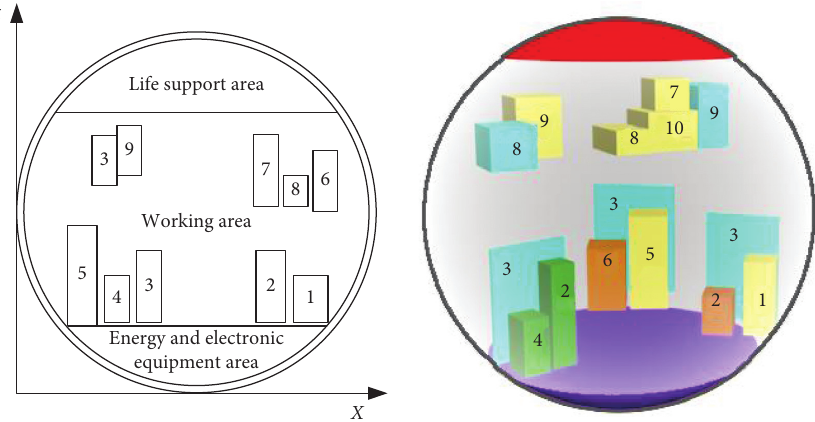
Figure 7: Model of space layout of equipment in the